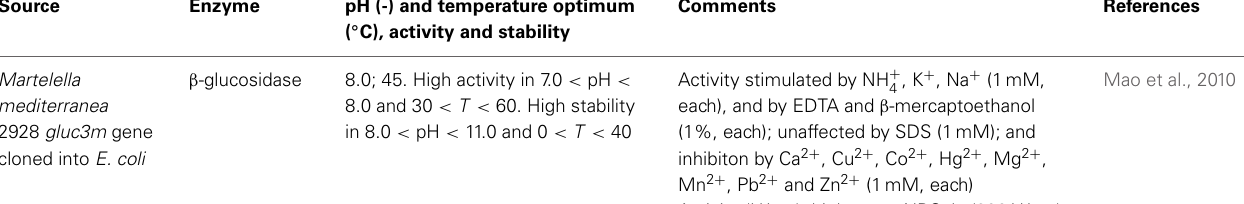
Table 4 | Effect of operational conditions in the performance of some recombinant β -glucosidases. Source